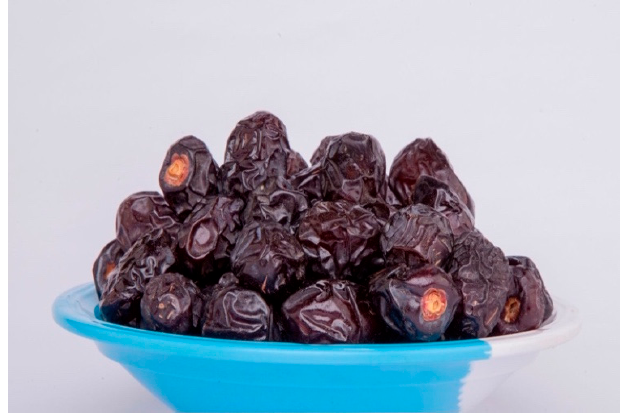
Figure 3. Sample of Al-ajwa dates.